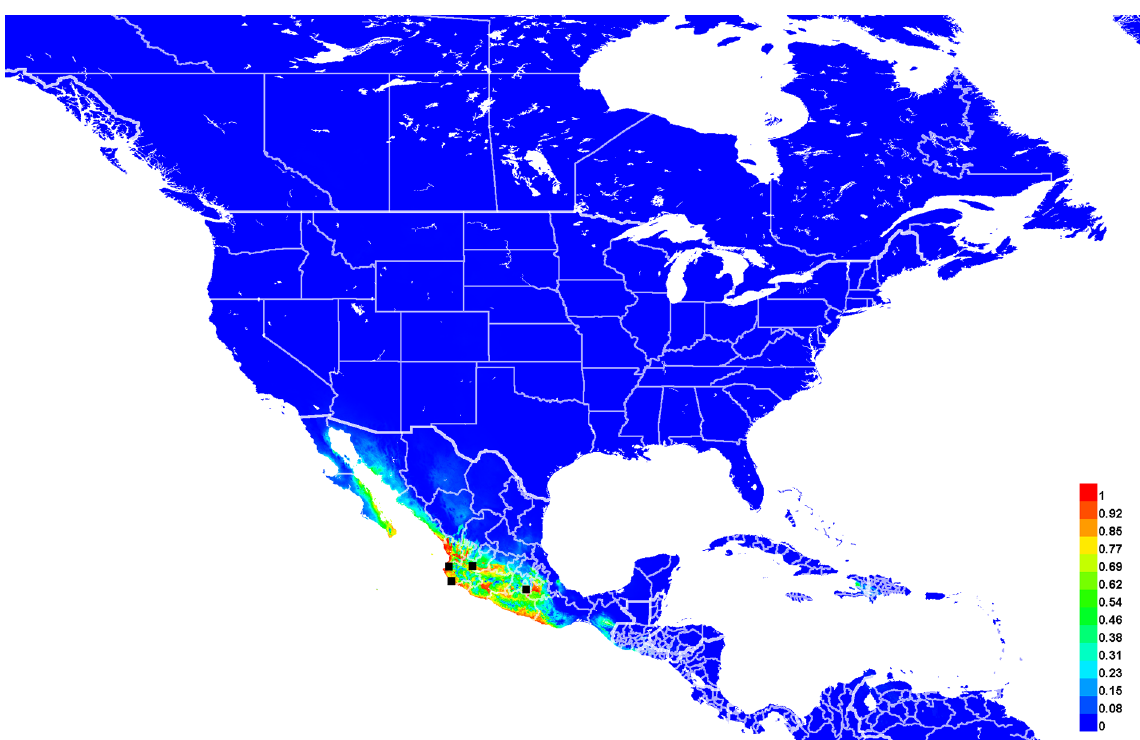
Fig. 33. Georeferenced collection records of Lasioglossum ( D. ) decorum sp. nov. (black squares) and predicted distribution by maximum entropy ecological niche modeling in Maxent (colour shading). Warmer colours indicate higher cloglog probability of occurrence. Due to the very small number of records, this distribution should be interpreted with